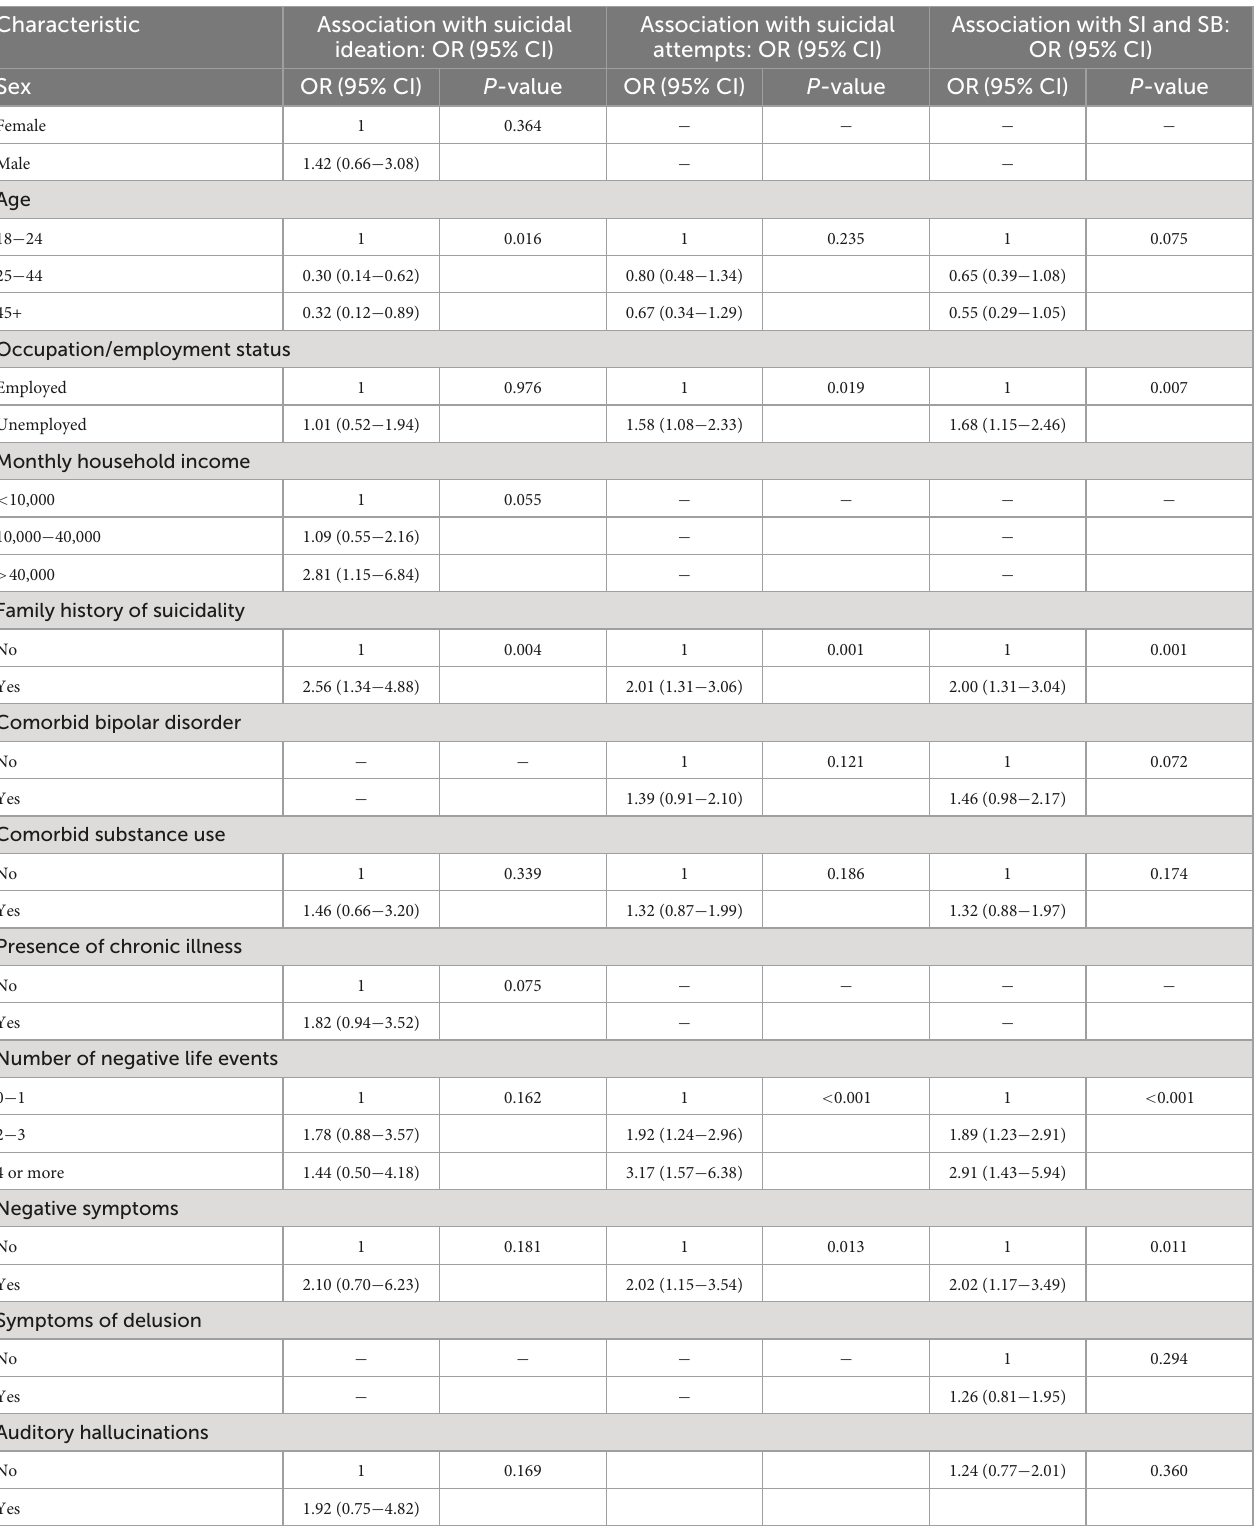
TABLE 3 Results from multivariate analysis of risk factors for suicidality, N = 619. Characteristic Association with suicidal